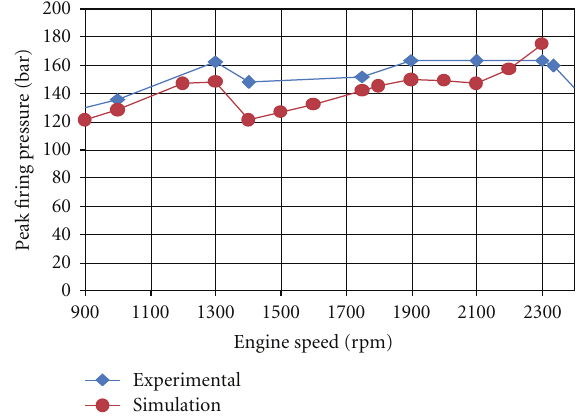
Figure 4: Comparison of experimental and simulated values of in- cylinder pressure (2300rpm; 100% load).